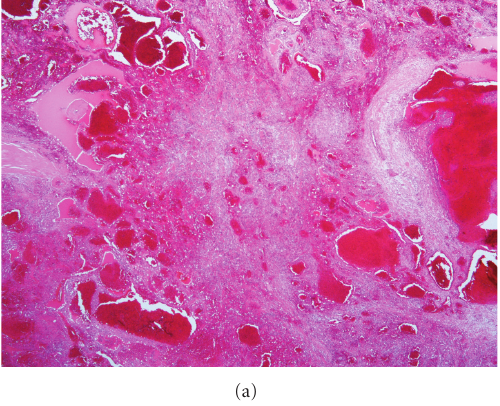
may indicate that the SCH was associated with vascular abnormalities in the